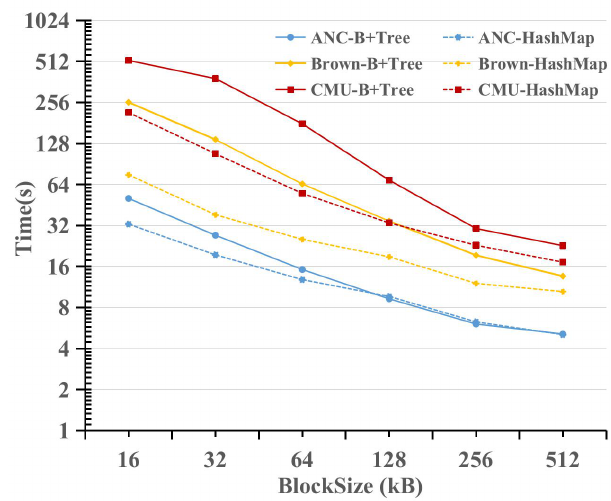
Figure 7. Comparison of the time between B+Tree and HashMap to update 5000 words.